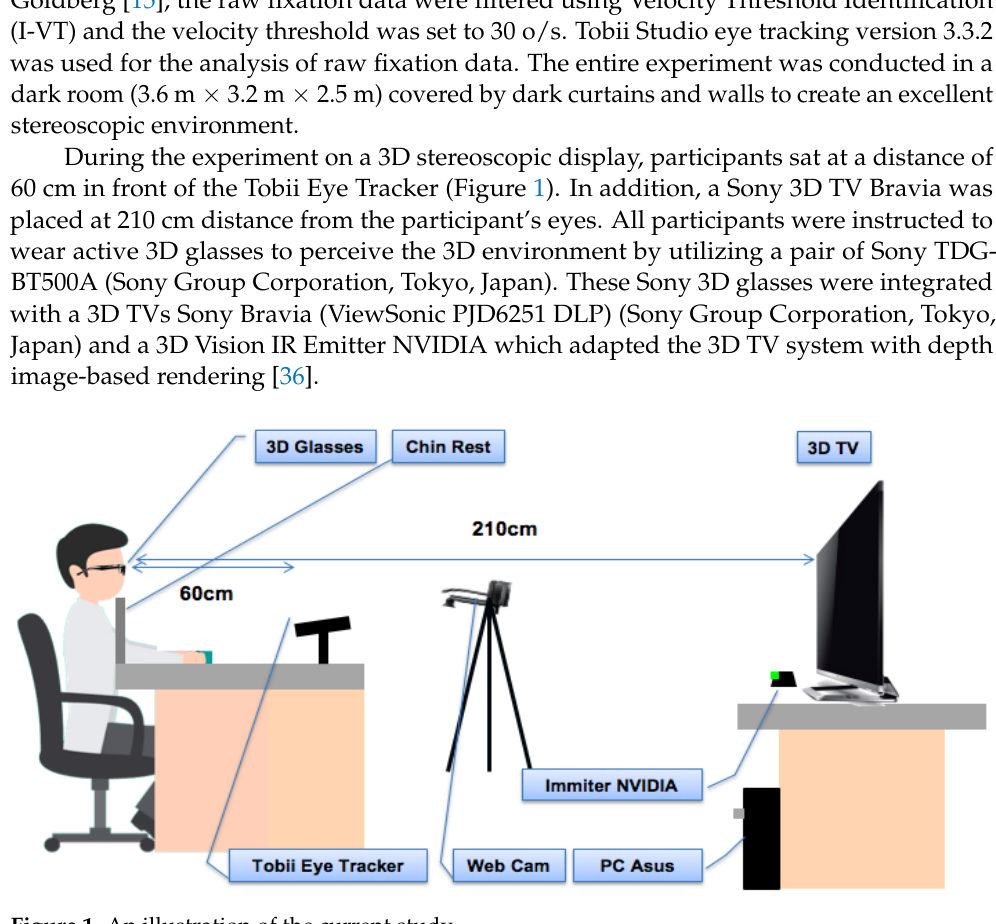
Figure 1. An illustration of the current study.